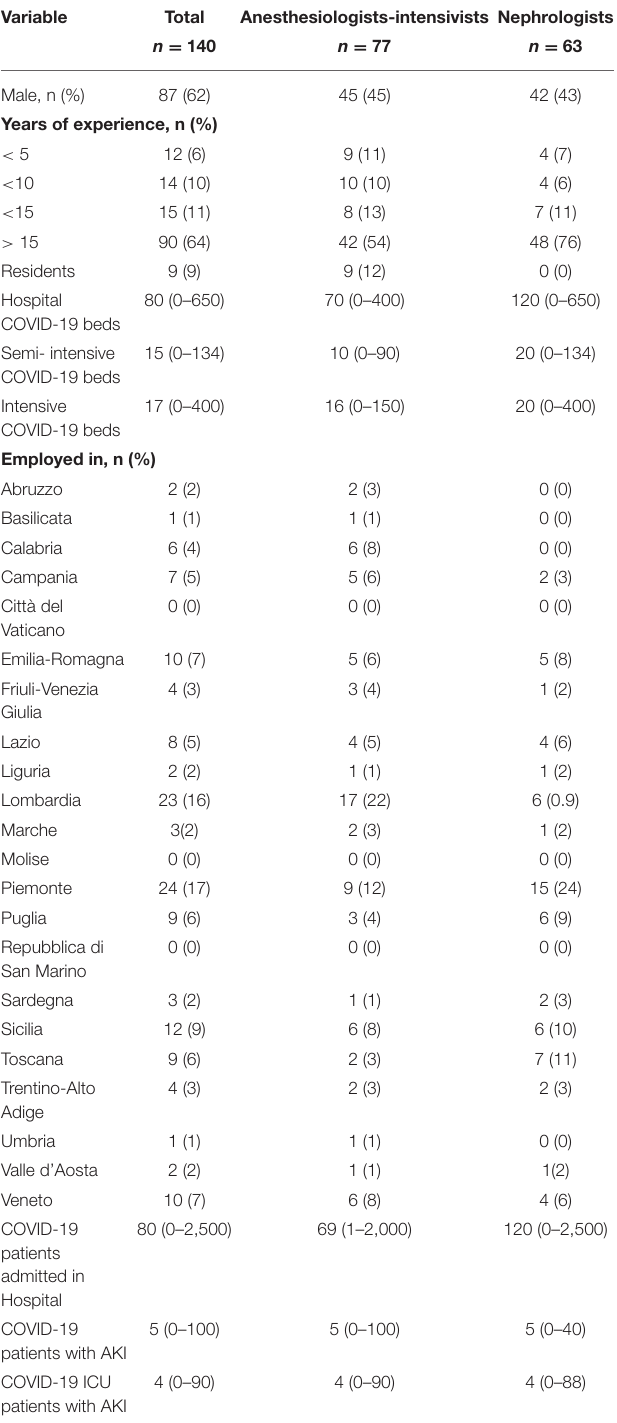
TABLE 1 | Baseline